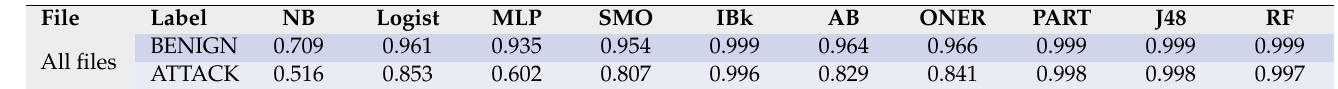
Table 14. F1 performance results in binary classification for the complete